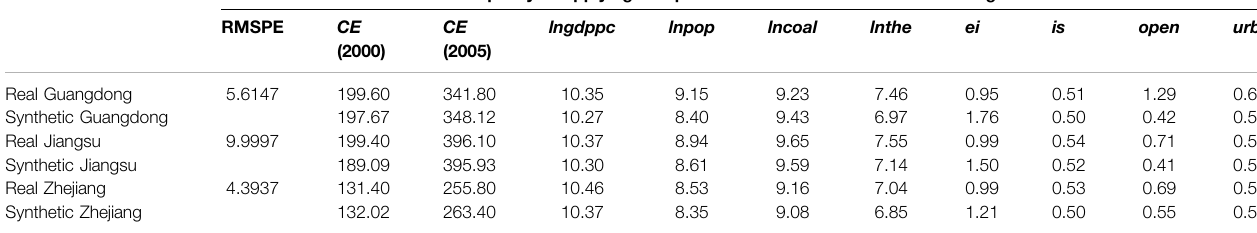
TABLE 3 | RMSPE comparison chart.